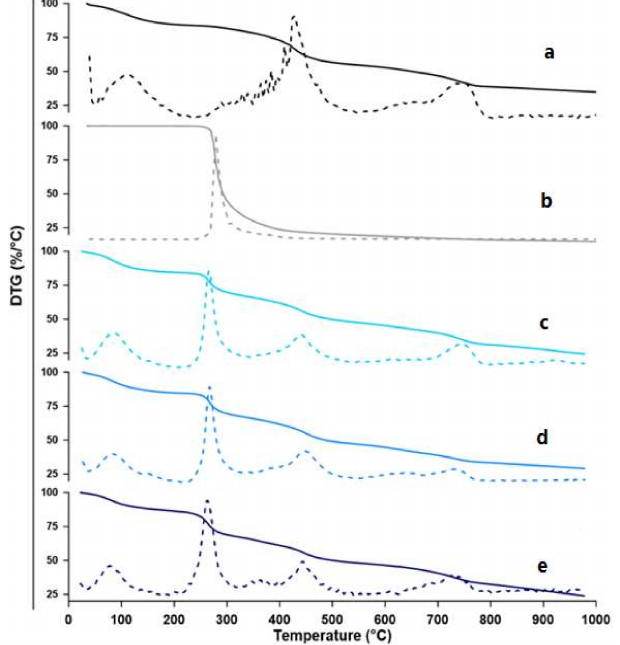
Figure 3. TGA/DTG curves of following: ( a ) sulfonatocalix[4]naphthalene (C), ( b ) meloxicam (ME), ( c ) physical mixture (PM), ( d ) kneaded (KN), and ( e ) coevaporate (CO)